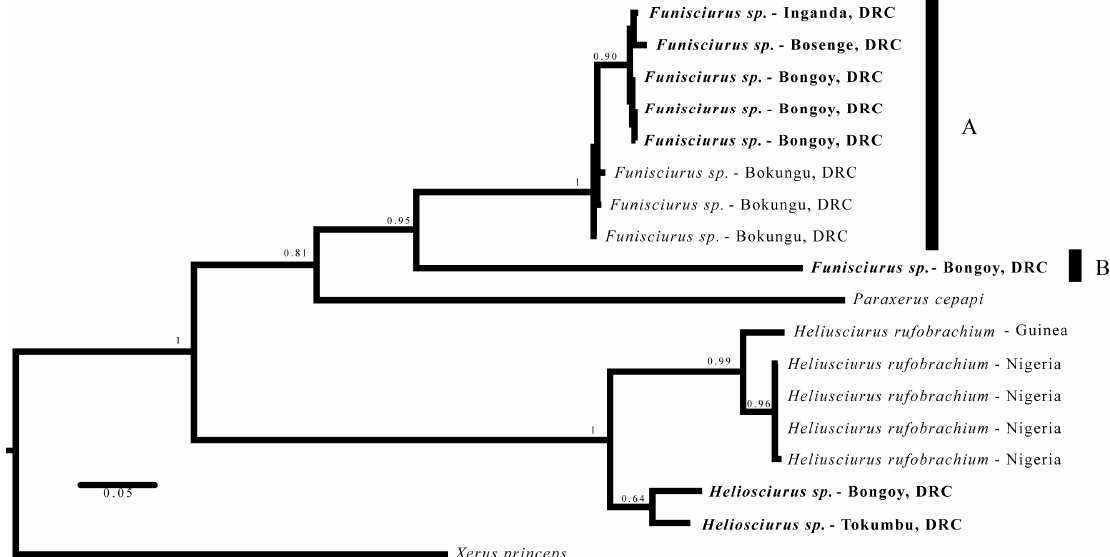
Figure 3. Molecular phylogenetic analysis by Bayesian inference. Majority rules consensus tree generated with MrBayes 3.2.2. Numbers above nodes indicate Bayesian posterior probabilities. Samples with bold font were collected by this study. Letters A and B indicate lineages within the genus Funisciurus that warrant further examination, as they are at least 24% divergent from their recovered sister taxon.